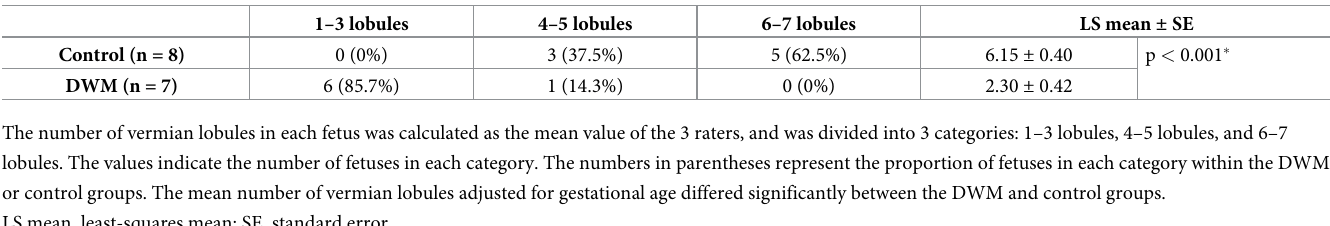
Table 3. Distribution of the number of vermian lobules in the DWM (n = 7) and control groups (n =